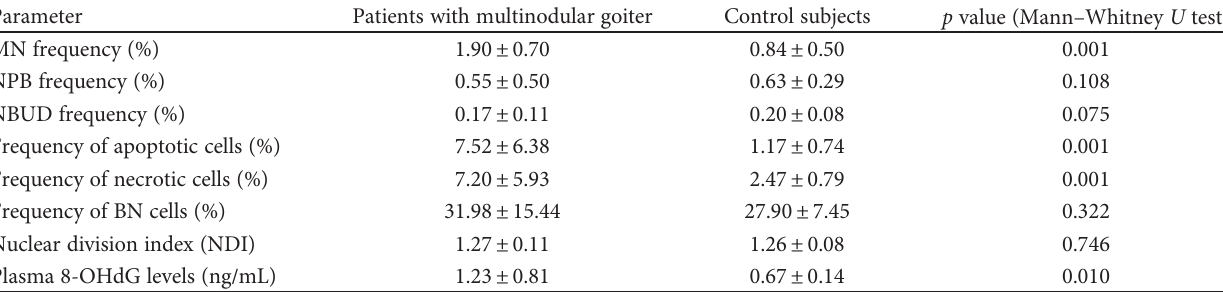
Table 2: CBMN-cyt assay parameters and plasma 8-OHdG levels in patients with multinodular goiter and control subjects (mean ± SD). Parameter